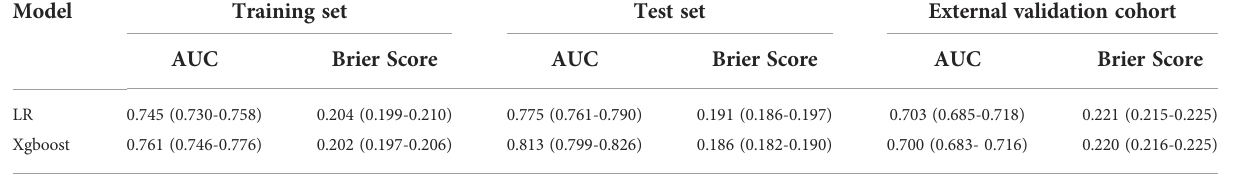
TABLE 2 The comparison of Xgboost and nomogram (LR) model.